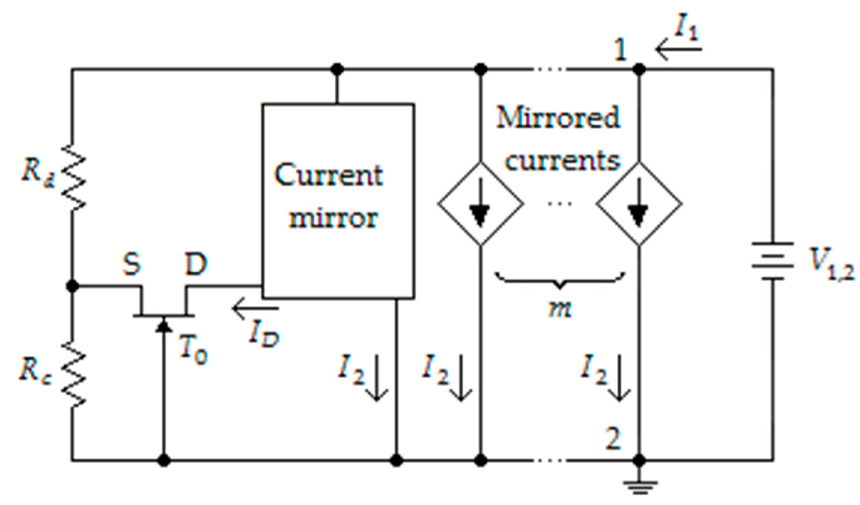
Figure 1. General two-terminal NDR circuit with multiple-output current mirror.